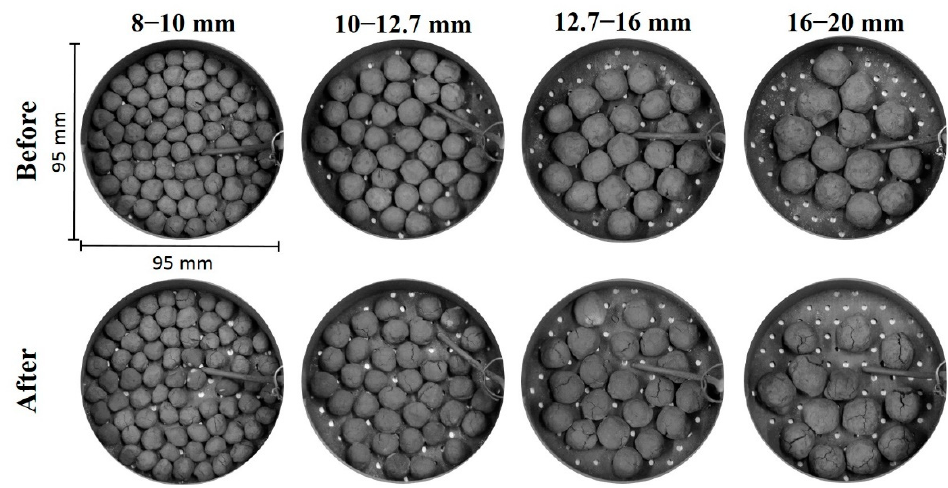
Figure 6. Digital camera images of the samples before (upper) and after (lower) the reducibility tests.